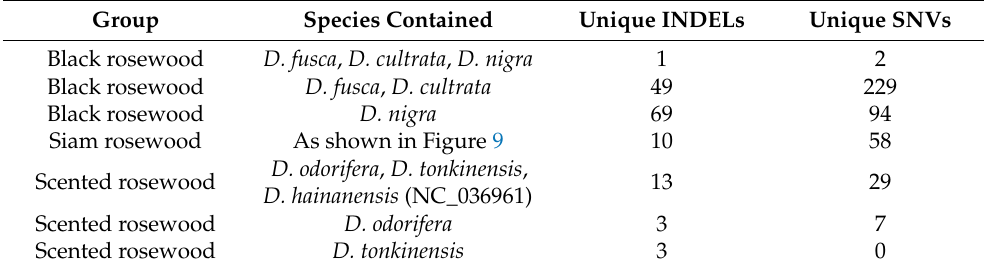
Table 2. Number of candidate molecular markers for black, Siam and scented rosewood. Group Species Contained Unique INDELs Unique SNVs Black rosewood D. fusca , D. cultrata , D. nigra 1 2 Black rosewood D. fusca , D. cultrata 49 229 Black rosewood D. nigra 69 94 Siam rosewood As shown in Figure 9 10 58 D. odorifera , D. tonkinensis , 13 29 Scented rosewood D. hainanensis (NC_036961) Scented rosewood D. odorifera 3 7 Scented rosewood D.